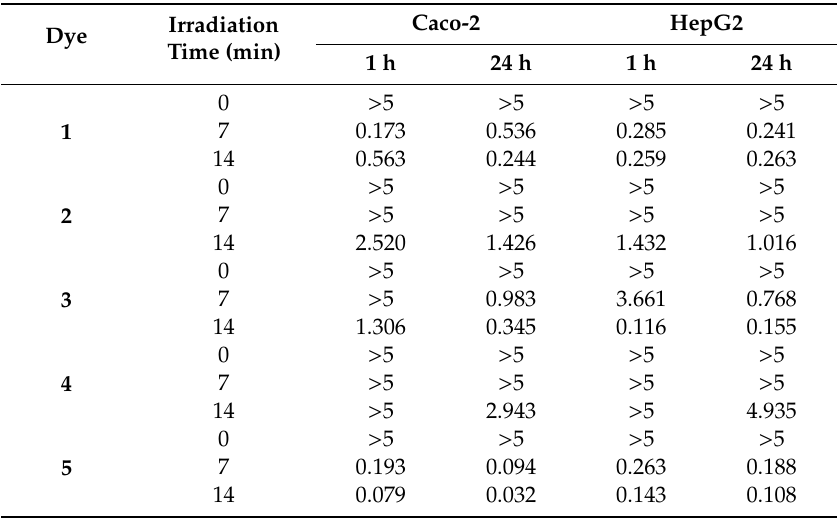
Table 2. In vitro cytotoxicity activity (IC 50 values, µ M) of dicyanomethylene squaraine dyes 1 – 5 against Caco-2 and HepG2 cells exposed to di ff erent irradiation times (0, 7 and 14 min) and di ff erent incubation periods with the irradiated dyes (1 and 24